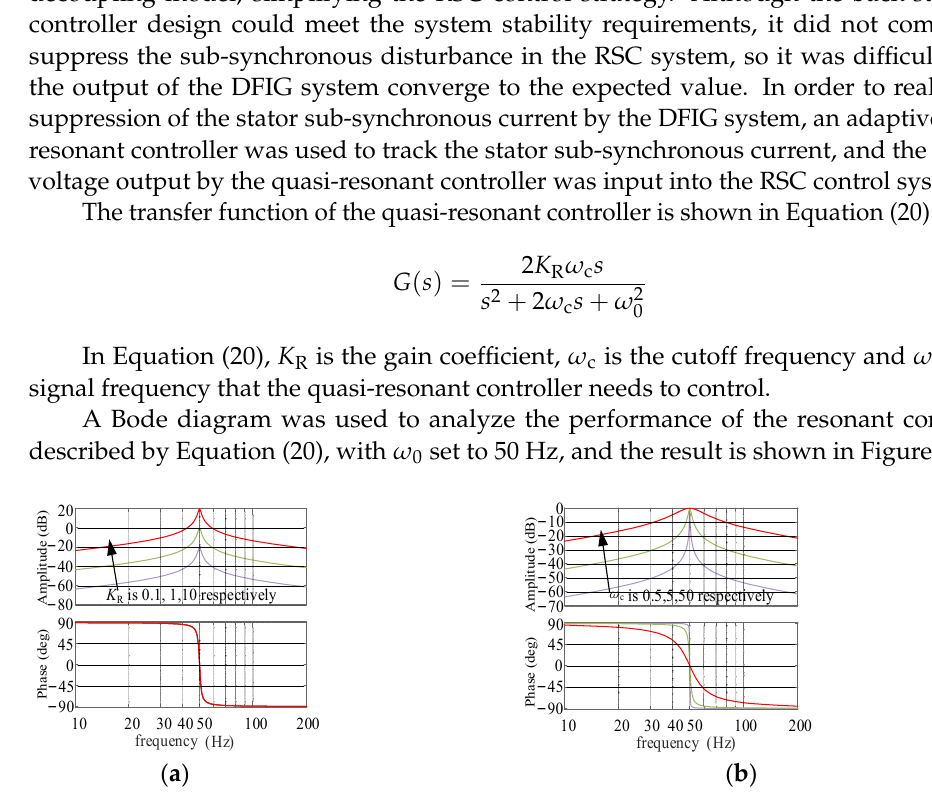
Figure 4. Bode diagrams of G( s ) as K R and ω c change: ( a ) the value of K R changes; ( b ) the value of ω c changes.